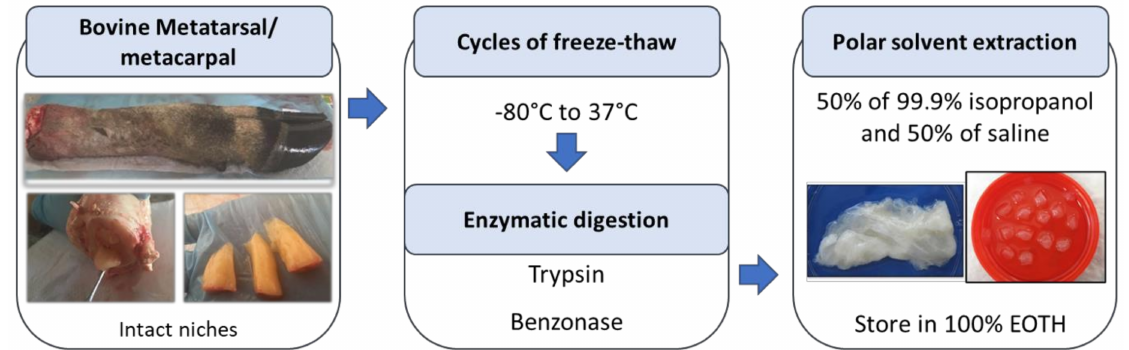
Figure 2. Graphical summary of the decellularization process. More details of the protocol in Bianco et al.